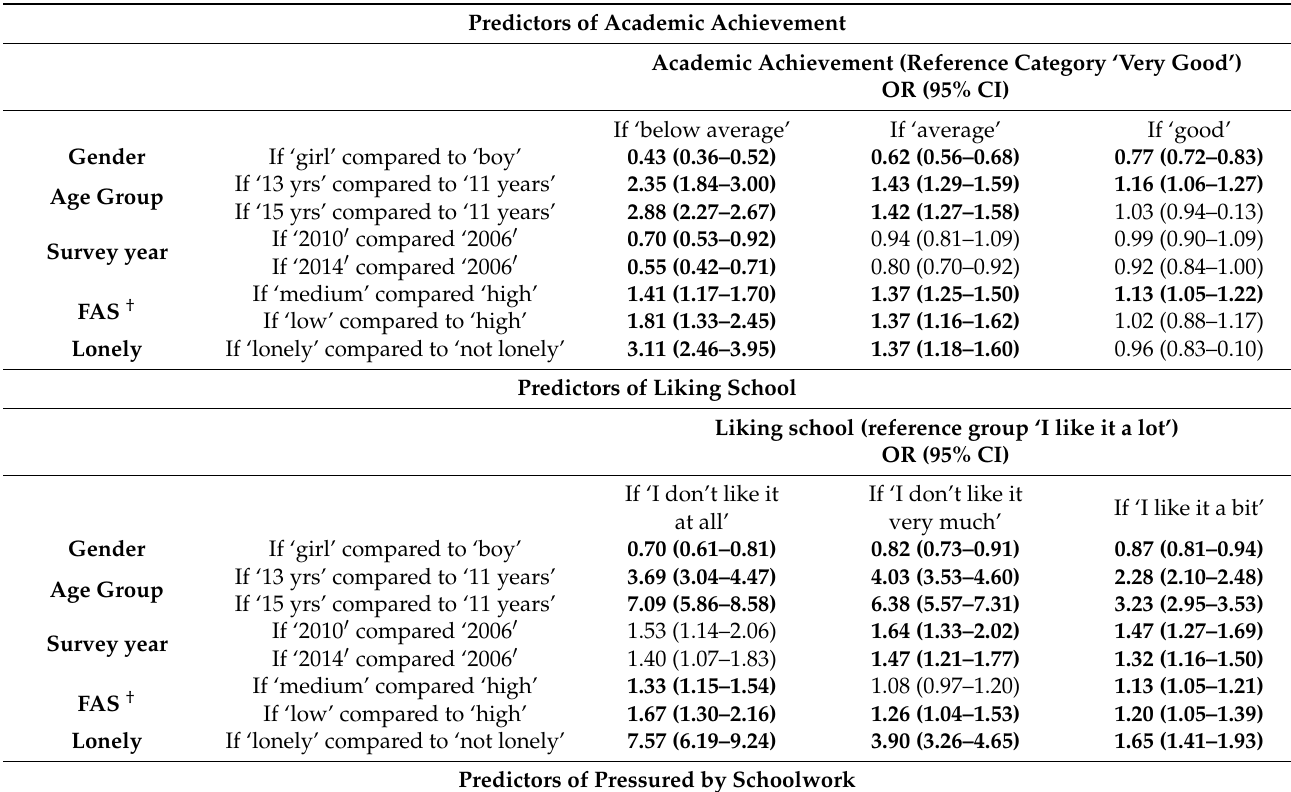
Table 3. MLM multinomial regression—Predictors of School